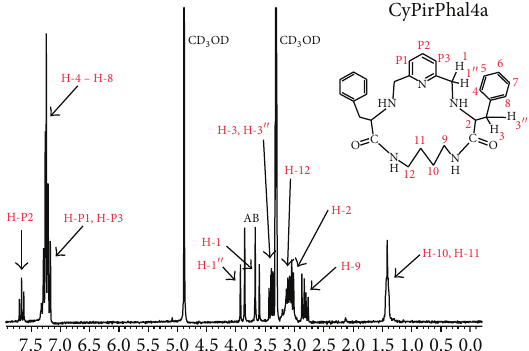
Figure 3: 1 H NMR spectrum of CyPirPhal4a in CD 3 OD.